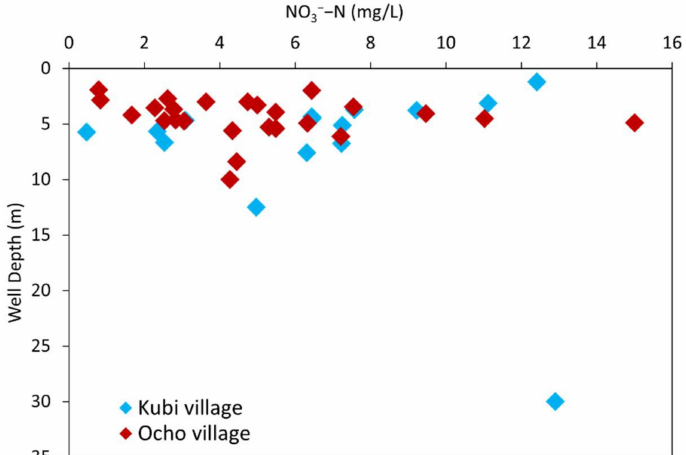
Figure 5. NO 3 − − N concentration vs. well depth in shallow wells in the study